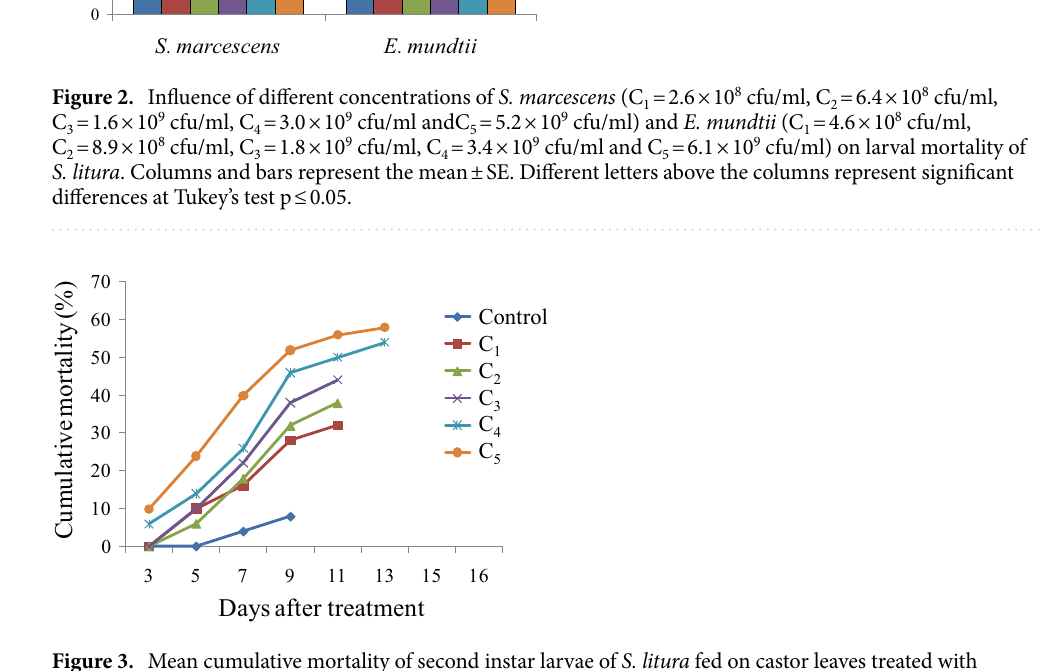
caused significantly higher larval mortality relative to control. The leaves treated with different concentrations of S. marcescens caused 32–58% mortality in S. litura larvae (F = 15.20**, p ≤ 0.05) (Fig. 2). The mortality rate increased in a concentration dependent manner. Similar results were obtained due to E. mundtii cell suspension that caused 26–52% mortality in S. litura larvae (F = 22.64**, p ≤ 0.05) (Fig. 2). The larval mortality started after 3rd day of treatment at higher concentrations (3.0 × 10 9 cfu/ml and 5.2 × 10 9 cfu/ml) of S. marcescens and con- tinued till 13th day (Fig. 3). Maximum larval deaths were observed with cumulative mortality of 52% at 9th day of treatment. Similarly in case of E. mundtii, the larval mortality started after 3rd day of treatment at the highest concentration (6.1 × 10 9 cfu/ml) and continued for fifteen days (Fig. 4). The LC 50 values for both the bacteria were calculated using Probit analysis, that came out to be 2.4 × 10 9 and 5.6 × 10 9 cfu/ml respectively for S. marc- escens and E. mundtii . Relative to control, the infected larvae showed the symptoms of sluggishness, cessation of feeding and the dead larvae became black in colour, flaccid but with intact integument (Fig. 5a–c). Bacterial treatment also influenced the development of insect. The larval period tended to increase but sig- nificant effect was observed at higher concentrations (Table 1). At the highest concentration of S. marcescens , the larvae took 14.88 days to pupate in comparison to 12.06 days in control (F = 6.05, p ≤ 0.05). The pupal period was also affected at the highest concentration. The overall development period from larva to adult extended sig- nificantly at higher concentrations i.e. 3.0 × 10 9 and 5.2 × 10 9 cfu/ml where the insect took 23.28 and 24.98 days respectively in comparison to 20.96 days in control (F = 10.51, p ≤ 0.05) (Table 1). Similar effects were observed due to E. mundtii where the larval period prolonged significantly by 2.59 to 4.03 days at higher concentrations i.e. 3.4 × 10 9 and 6.1 × 10 9 cfu/ml with respect to control (Table 1). Signifi- cant effect was also detected on pupal period that ultimately extended the total development period by 2.68 to 5.43 days at concentrations ranging between 1.8 × 10 9 to 6.1 × 10 9 cfu/ml in comparison to control.